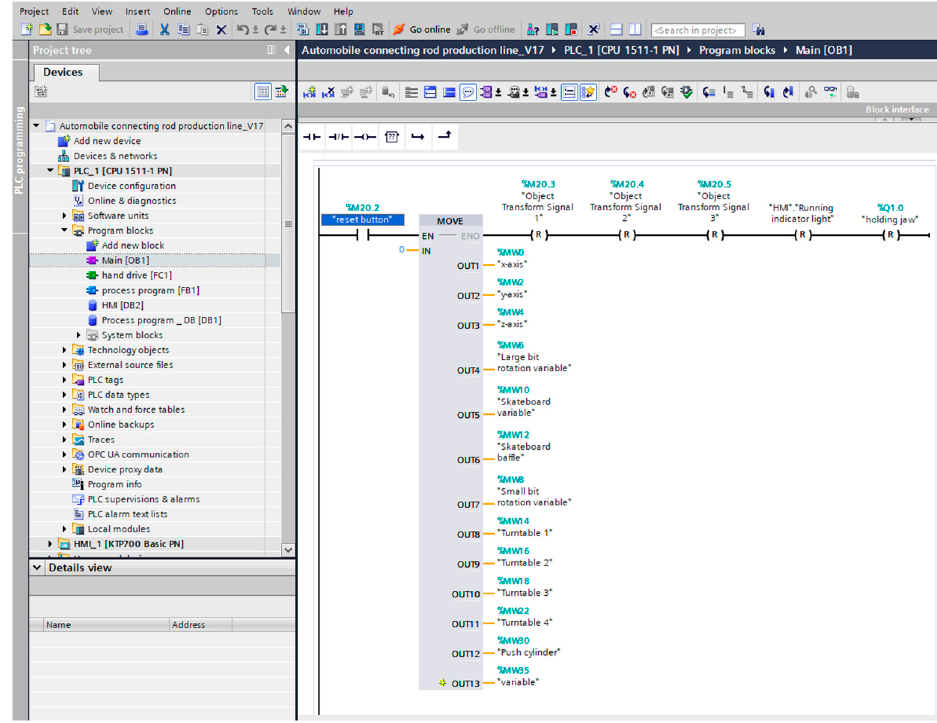
Figure 10. The main program.